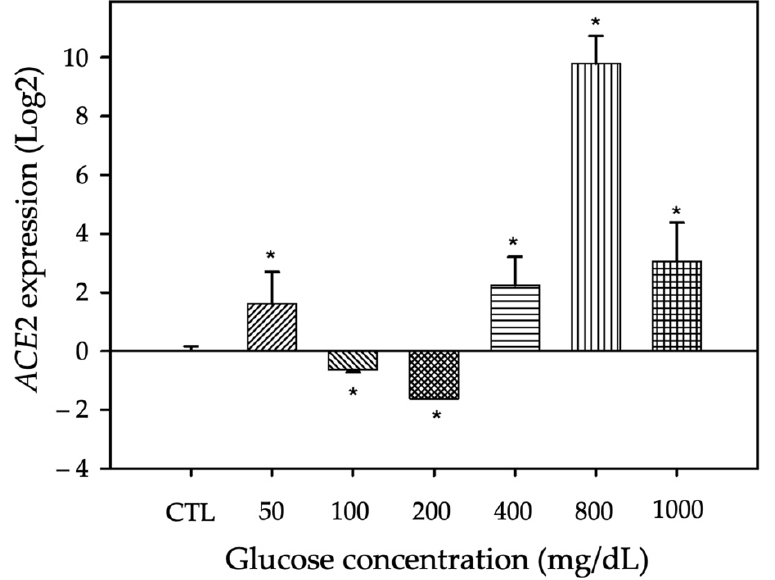
Figure 3. Fold change of ACE2 expression in A549 cells treated with 50, 100, 200, 400, 800 or 1000 mg/dL glucose for 72 h. Compared with the control, there were significant differences in the ACE2 expression level in cells treated with 200, 400 or 800 mg/dL glucose. The bars represent the control